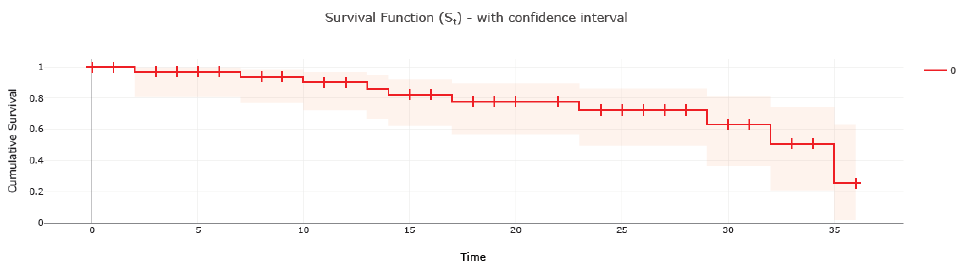
Figure 3. Kaplan–Meier analysis. The survival rate in the medical treatment group within 3 years. In the PEA group after 1- and 3-years post-surgery, a significant decrease in plasma BNP values (320 ± 174 vs. 291 ± 183 pg/mL p -value = 0.04 and 291 ± 112 vs. 248 ± 105 p = 0.03, respectively) and an increase in meters covered at the six-minute walk test (320 ± 62 vs. 336 ± 104 m p -value = 0.03 and 326 ± 115 vs. 400 ± 93 m p = 0.02, respectively) were observed. There was no statistically significant difference after 1 and 3 years in plasma BNP values or in meters covered at a six-minute walk test in the balloon pulmonary angioplasty group.